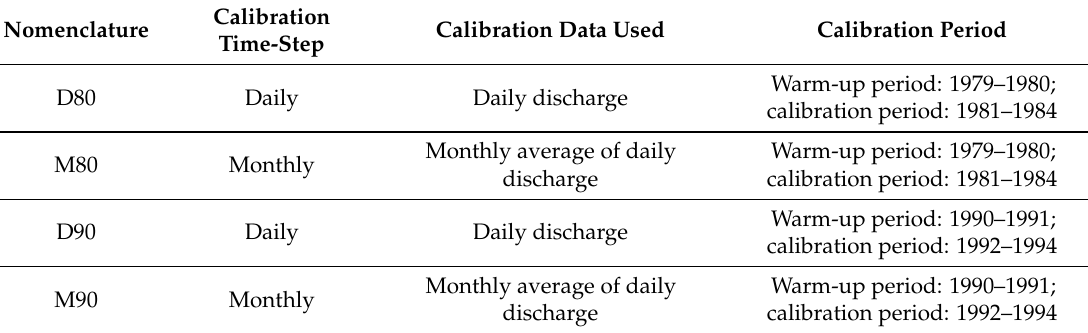
Table 3. Calibration cases used in the study. Observed discharge data, measured at Sripalpur, were made available by the